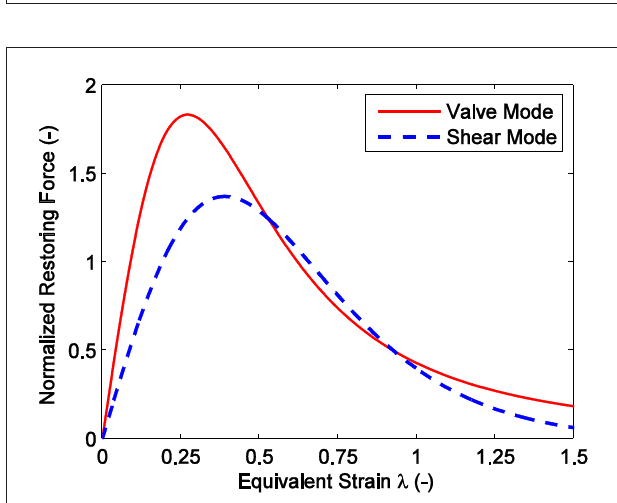
FIGURE 12 | Comparison of normalized restoring force response between simple dipole model and local field dipole model.